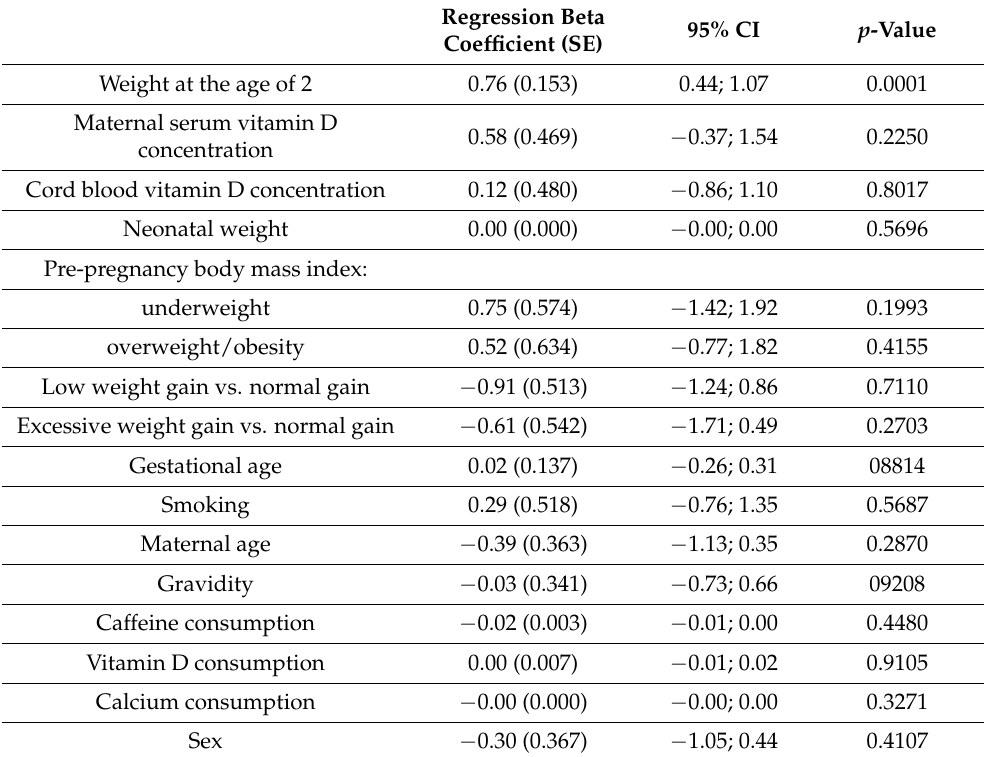
Table 4. Relationship between selected parameters and weight at the age of 4.